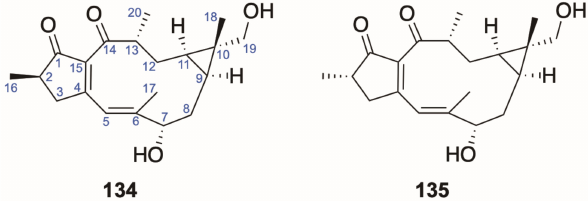
Figure 9. Structures of lathyrane-type diterpenoids ( 134 – 135 ).